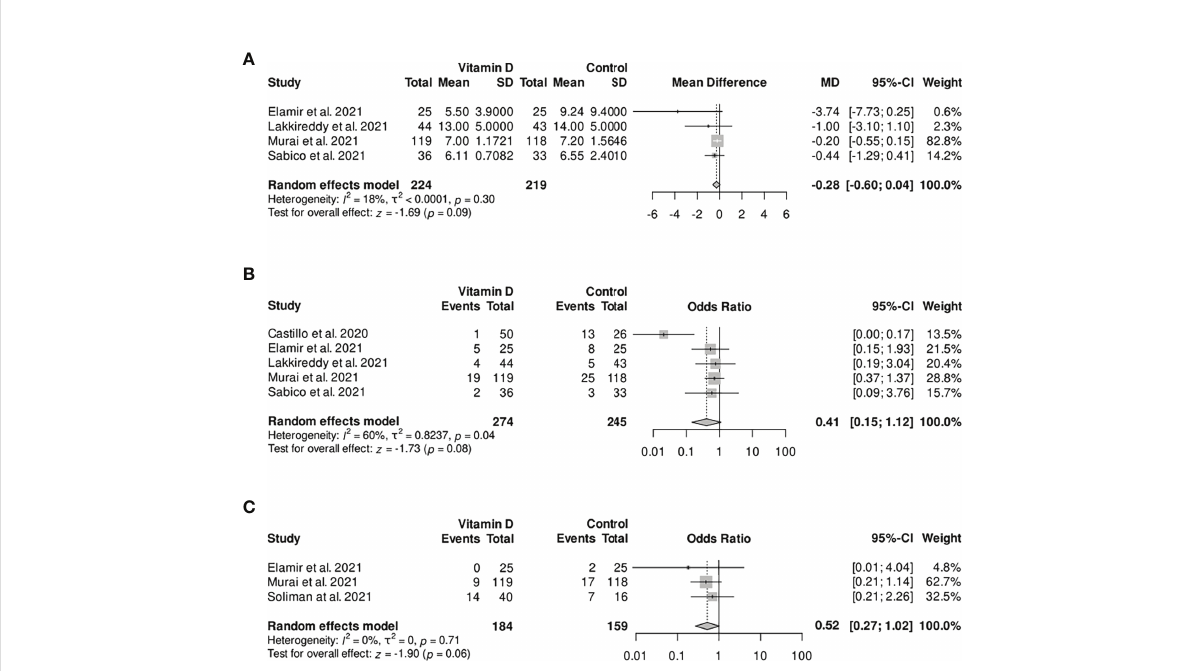
FIGURE 4 Forest plot random-effect model of various outcomes: (A) length of hospitalization; (B) need for ICU admission; (C) need for mechanical ventilation. CI, con fi dence interval; MD, mean difference; OR, odds ratio; SD, standard